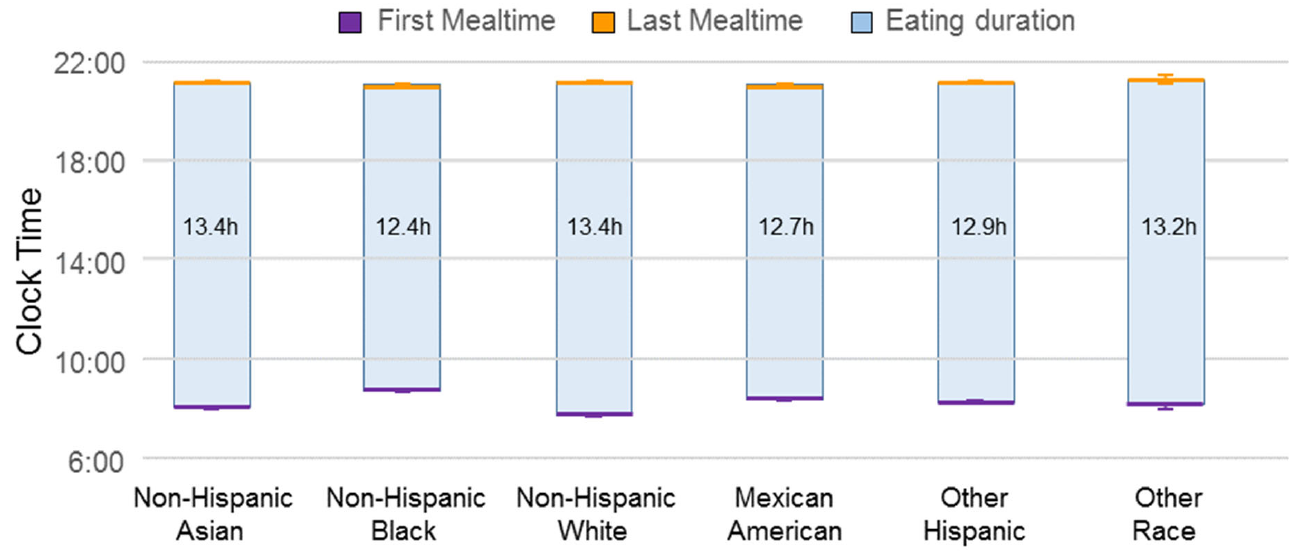
Figure 1. First mealtime (bottom of bar), last mealtime (top of bar), and eating duration (length of bar) by race and ethnicity.